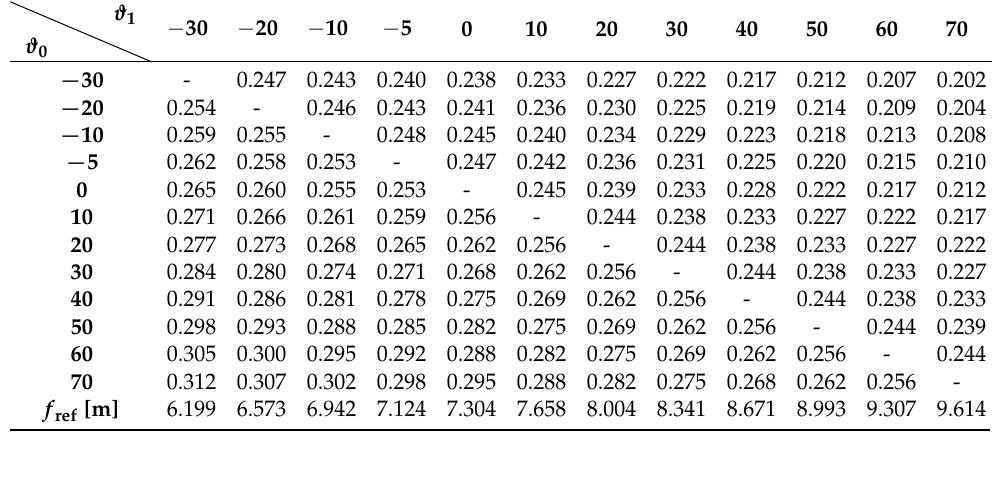
Table 5. Maximum absolute sag deviations ∆ f σ [m] caused by the incorrect determination of the conductor initial mechanical tension.